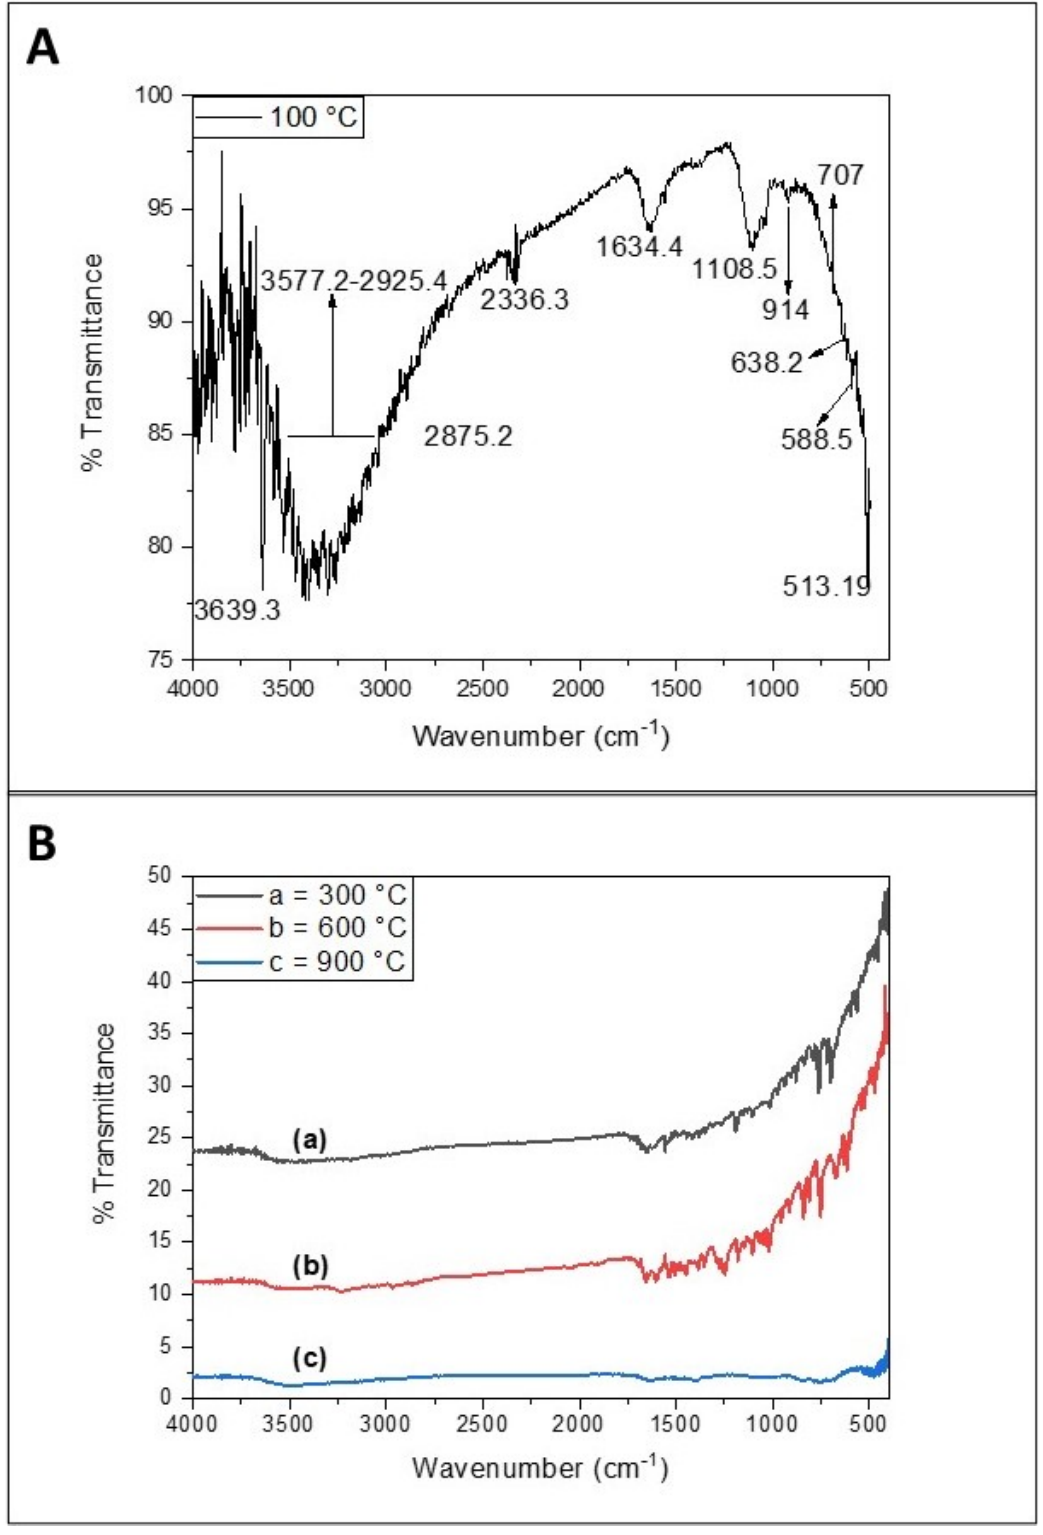
Figure 5. The FTIR spectrum of NiO ‐ SnO 2 NCs calcined at ( A ) 100 °C and ( B ) over 100 °C (temperature indicated).